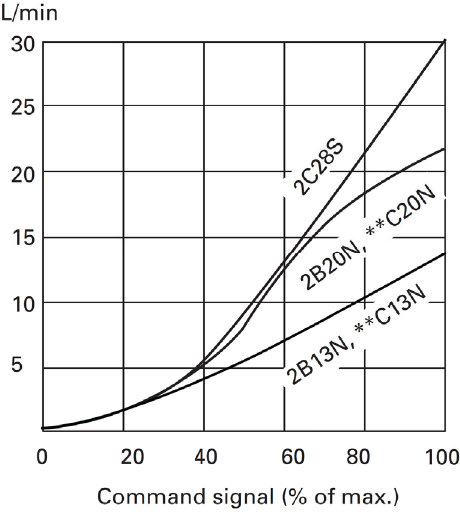
Figure 7. Control valve flow versus command signal. Courtesy of Eaton Corporation.